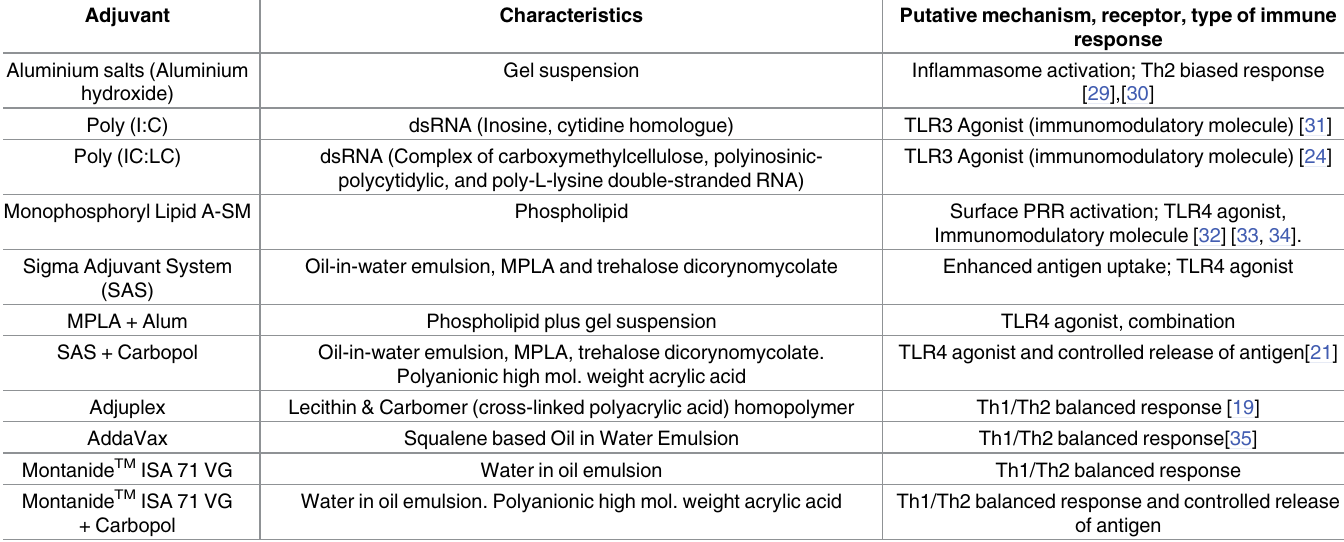
Table 1. Adjuvants and their proposed mode of action.